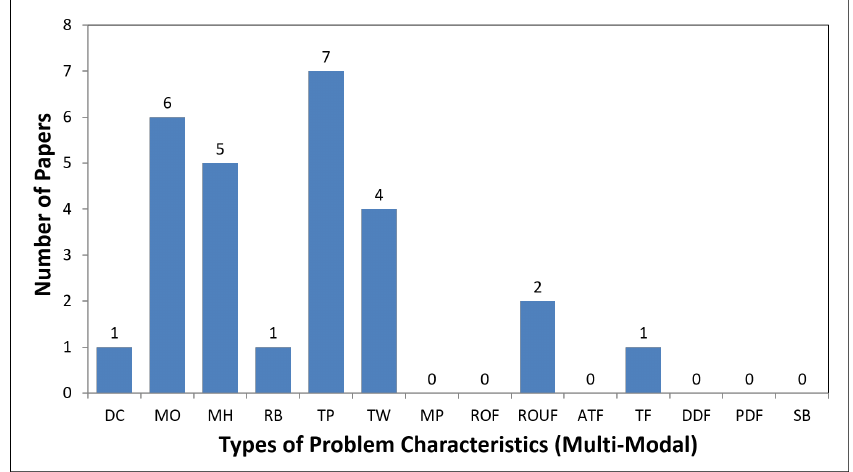
Figure 11. Distribution of Papers based on the Problem Characteristics: